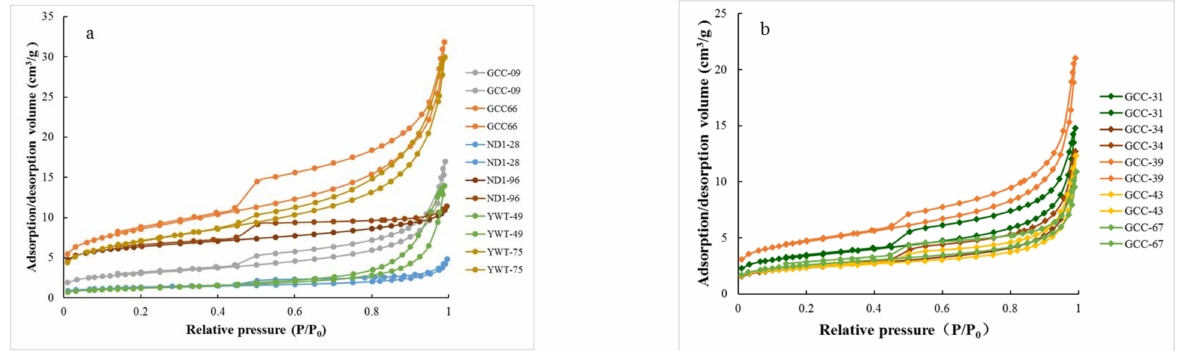
Figure 8. N 2 adsorption/desorption isotherms at low temperature (77 K) for siliceous shales ( a ) and argillaceous shales ( b